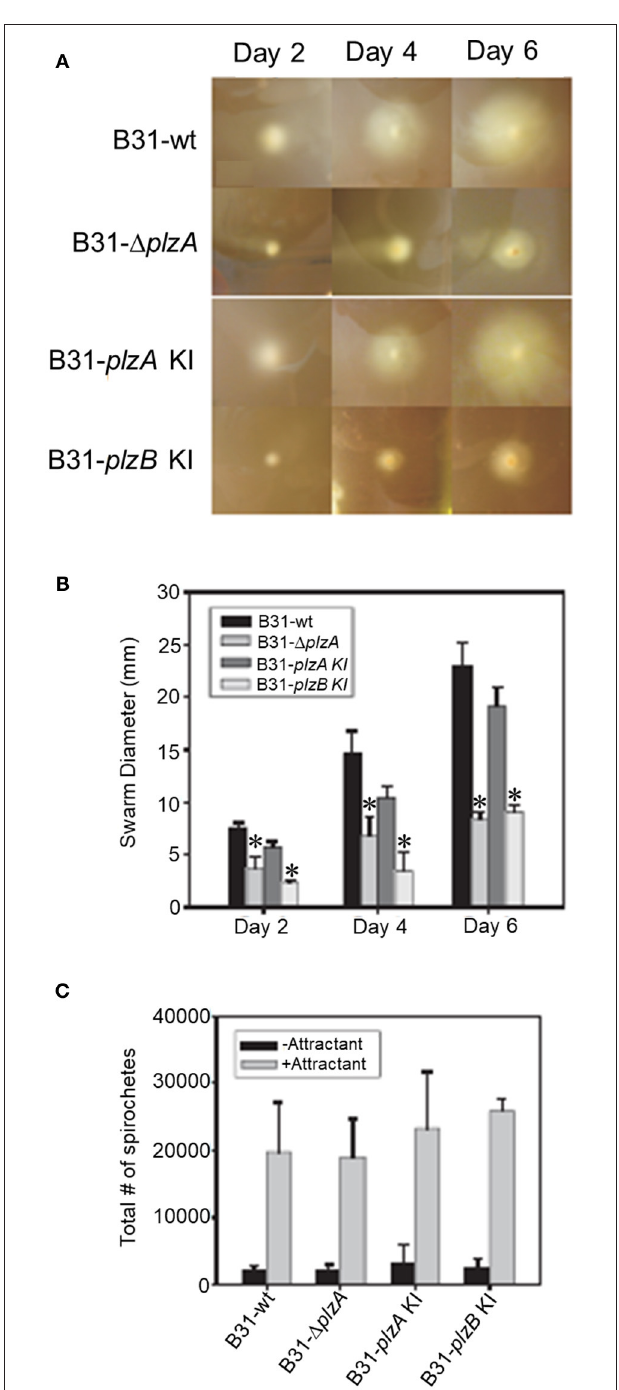
FIGURE 3 | Motility and chemotaxis analyses. B. burgdorferi B31-wt, B31- 1 plzA , B31- plzA KI, and B31- plzB KI were evaluated for motility using a “plate swarming” assay as detailed in the text. Photographs of representative plates taken 2, 4, and 6 days after inoculation of the plates are shown in (A) . The diameters of each expanding zone of growth was determined and are presented as bar graphs in (B) . In (C) , the results of capillary tube-based chemotaxis assays using N-acetyl glutamic acid as the chemoattractant are shown. The assays were conducted as detailed in the text and statistical significance was assessed using the One-Way ANOVA. *Statistical significance was assessed relative to wild type ( p < 0.05).